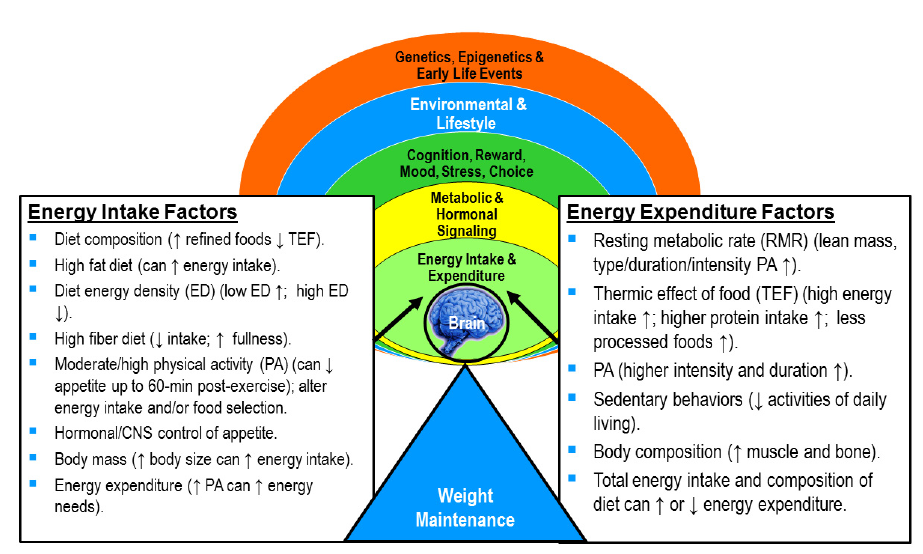
Figure 2. Some examples of the many factors regulating and influencing energy balance. Signals between the brain and body systems sense energy needs and help regulate body weight and composition. Genetics and early life events can affect the body’s ability to sense and manage weight, while environmental and lifestyle factors, including mood, stress, and reward factors, can override body signals for eating. Any change in body size and composition can alter both energy intake and expenditure. Information adapted from Galgani and Ravussin [10], Acheson et al. [11], Manore et al. [17], and Manore [18,19].